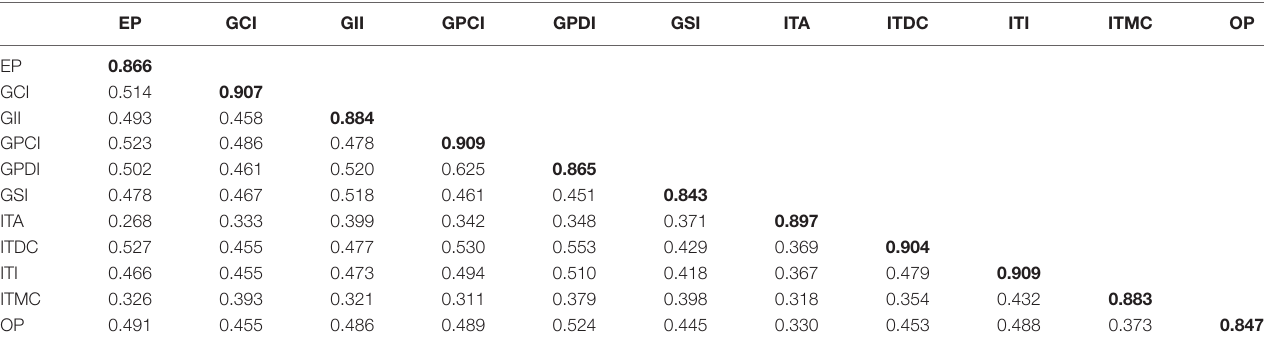
TABLE 3 | Fornell-Larcker